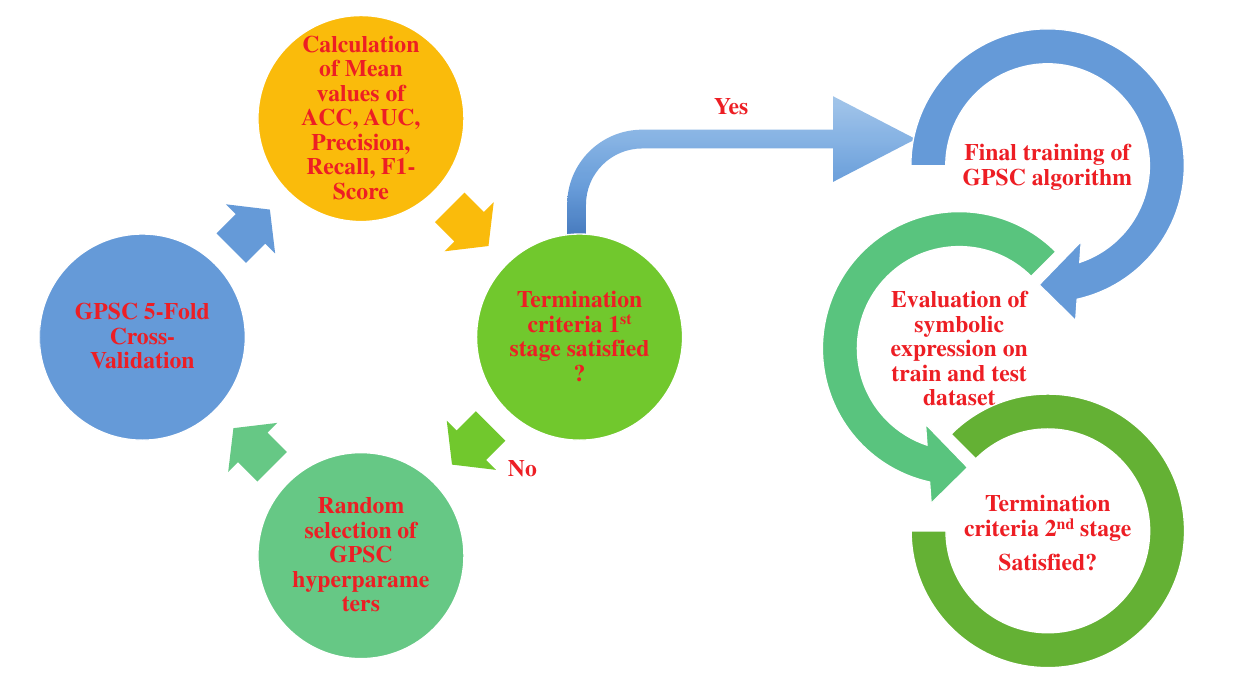
Figure 4. The schematic view of GPSC with random hyperparameter search and 5-fold